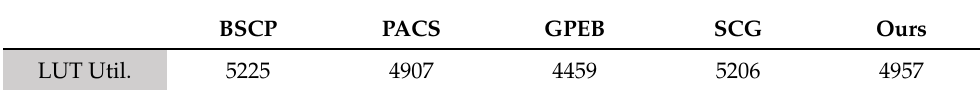
Table 10. Comparison of lookup-table (LUT) resource usage for FPGA implementation of a 2D convolution unit for various TEC